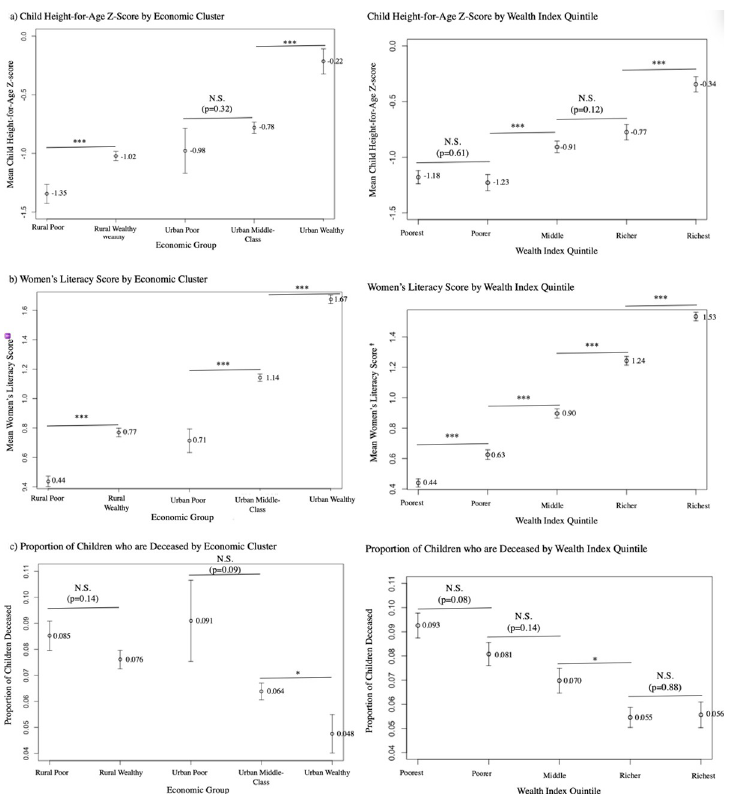
Fig 8. Mean Child HAZ, women’s literacy score, and proportion of children who are deceased for Ghanaian EconomicClusters and DHS Wealth Index quintiles. Caption: Horizontal bar indicates p-value for two-sample student’s t-tests between adjacent groups: � = p < 0.05, �� = p < 0.01, ��� = p < 0.005 †Literacy Score: 0 = “Cannot read at all”, 1 = “Able to read only parts of a sentence”, 2 = “Able to read whole sentence” Error Bars: Standard error of the